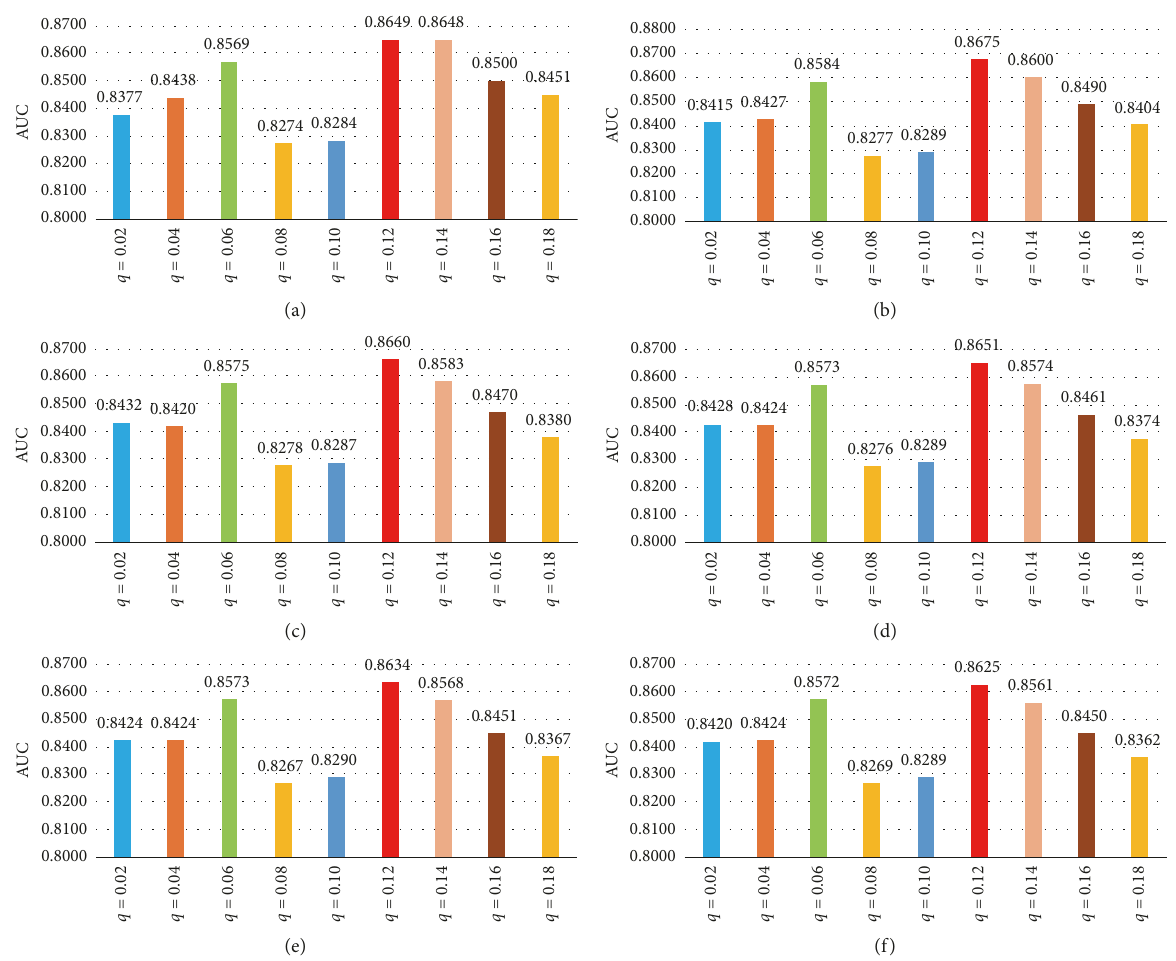
Figure 4: The influence of α and q on AUC. (a) α � 0 . 5, (b) α � 1, (c) α � 1 . 5, (d) α � 2, (e) α � 3, and (f) α � 5.